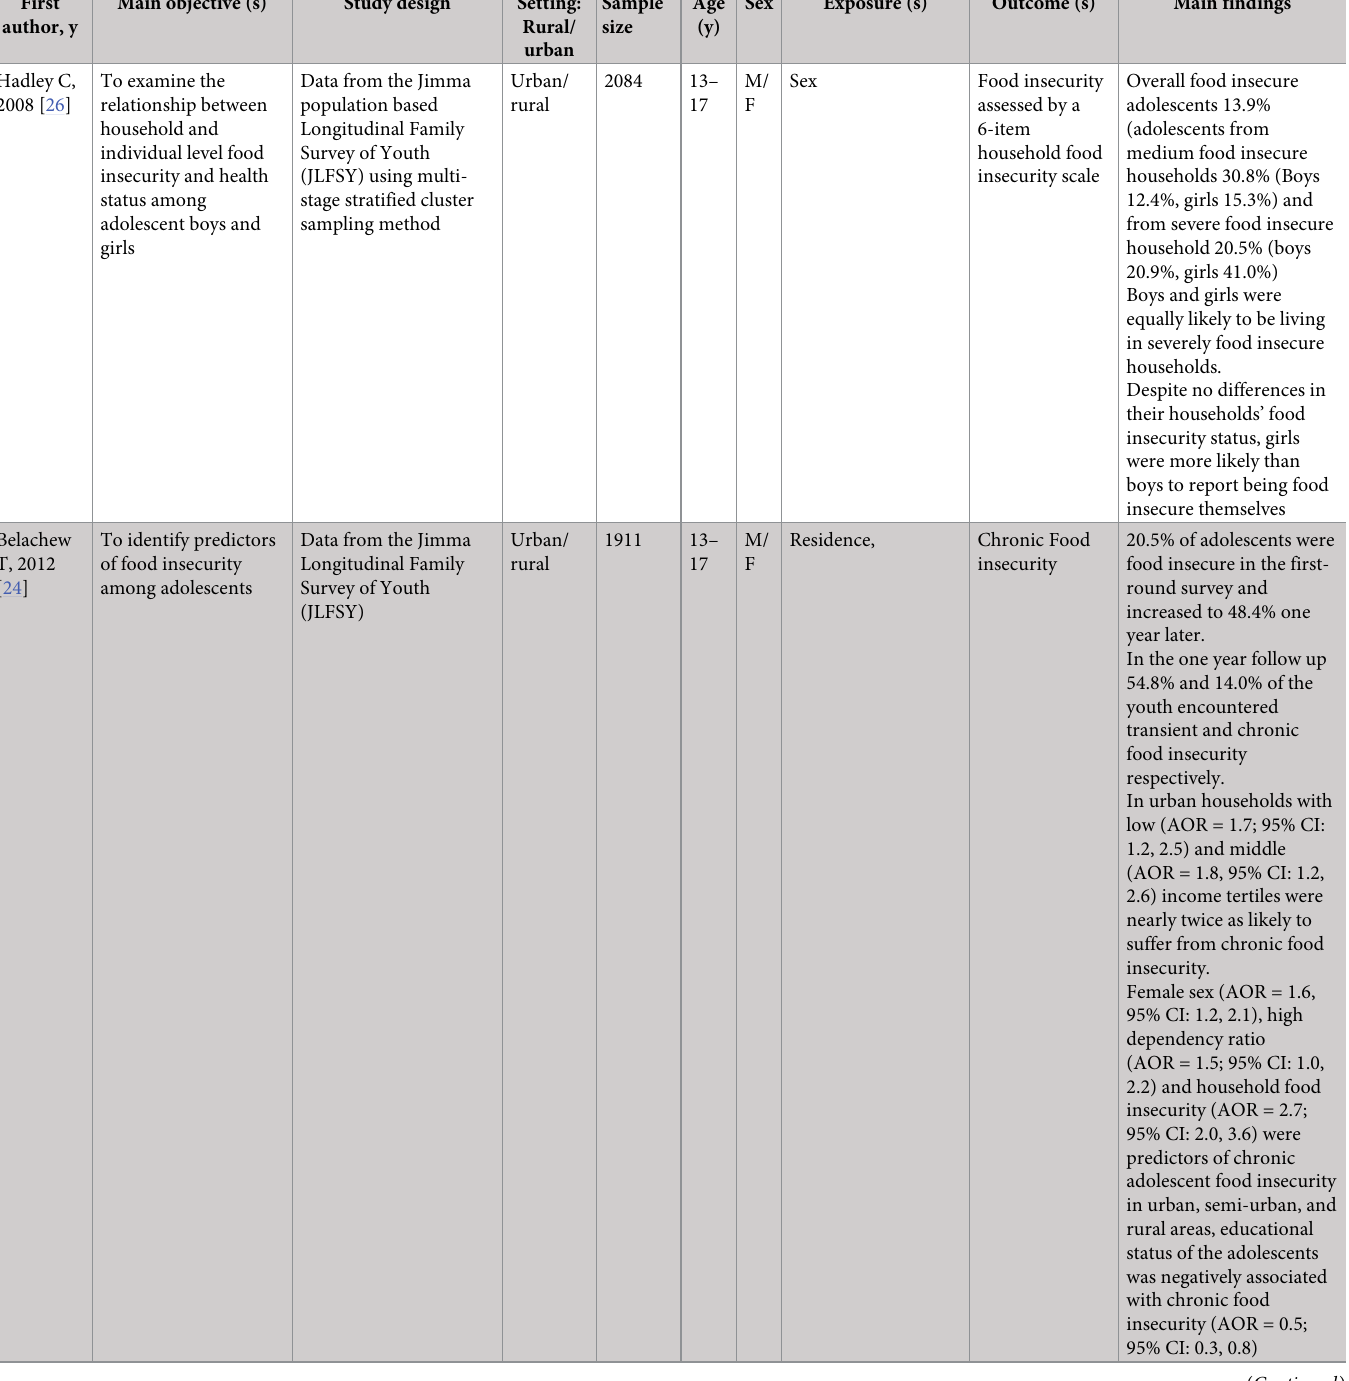
Table 4. Studies focusing on food